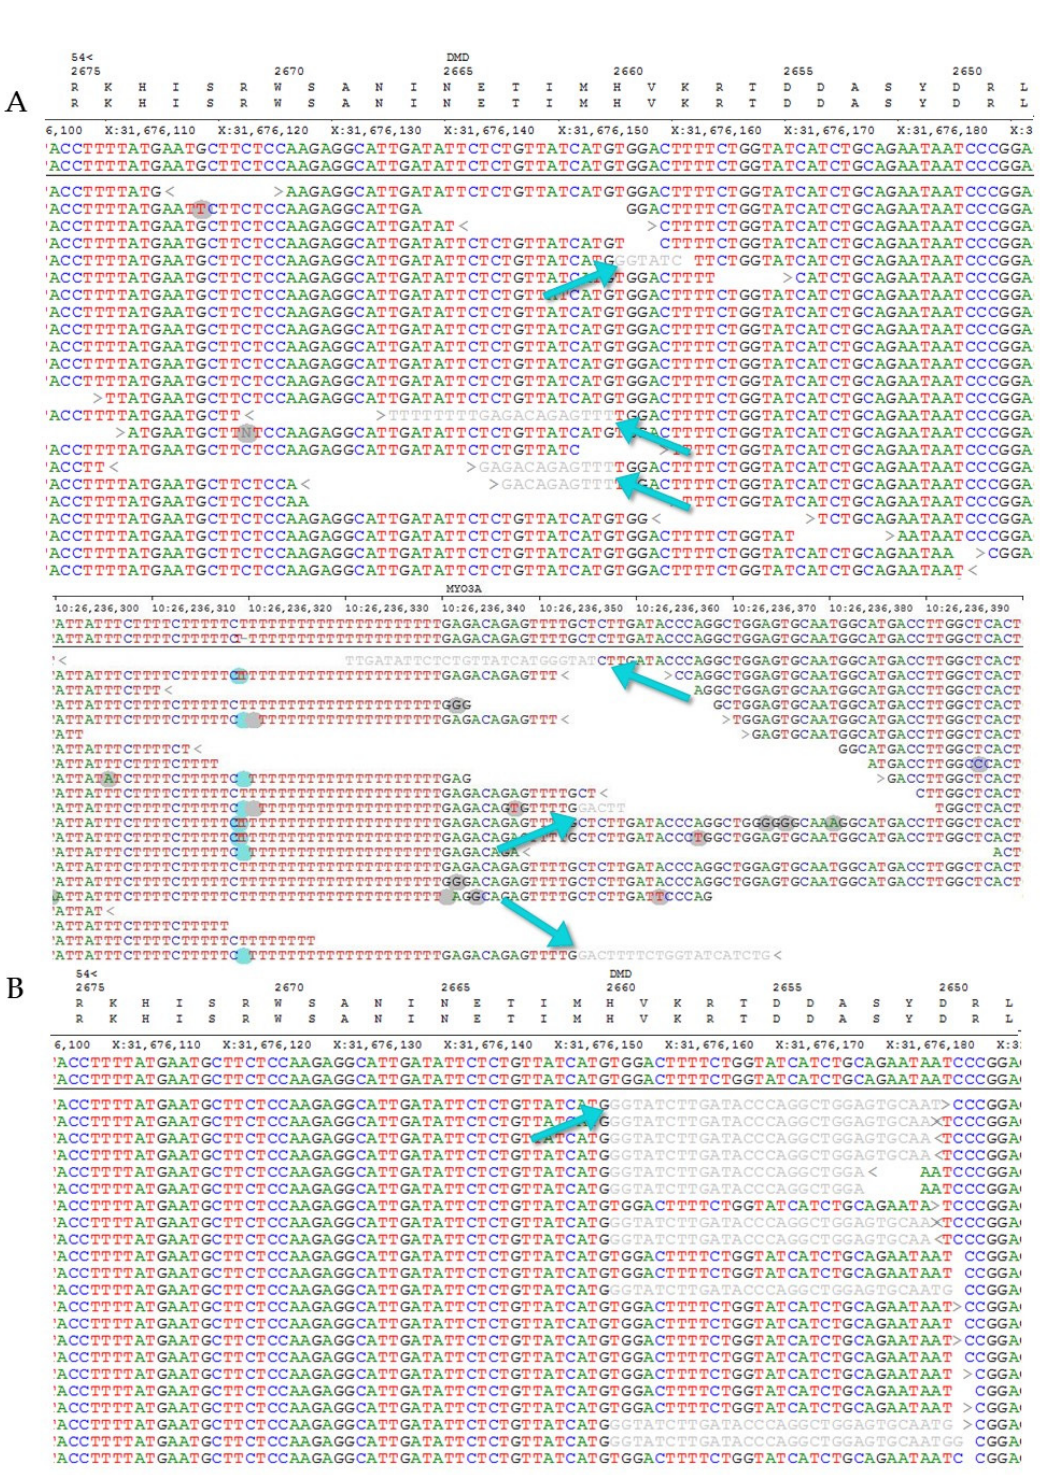
Figure 4. ( A ) The presence of split reads in whole genome sequencing data aligned to the breakpoints (shown in grey, indicated by blue arrows). The first part of the sequence of the reads is complementary with the sequence of the DMD gene on chromosome X, as shown in the upper part of the figure, whereas the other part of the sequence can be aligned to the MYO3A gene on chromosome 10, as shown in the lower part of the picture. The blue and grey circles in the reads indicate the alignment errors by the software. ( B ) The presence of split reads in the targeted next-generation sequencing data aligned to the breakpoints (shown in grey, indicated by blue arrows) in the DMD